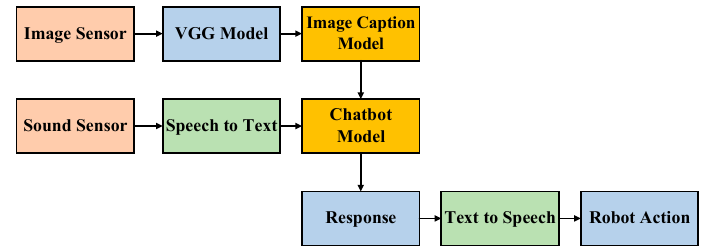
Figure 3. The architecture of the system.